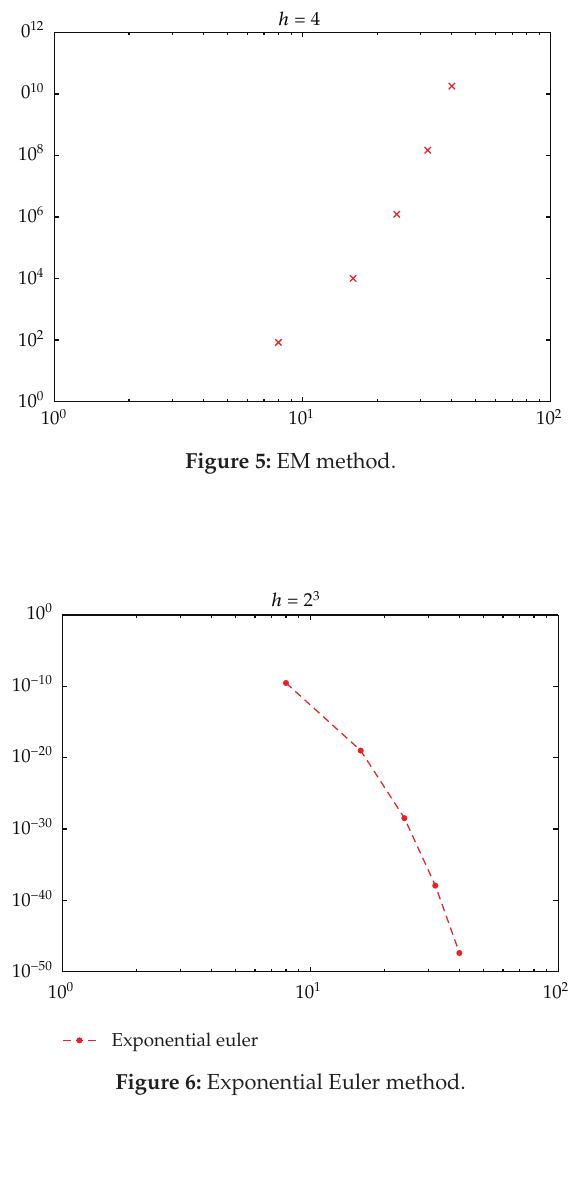
Figure 6: Exponential Euler